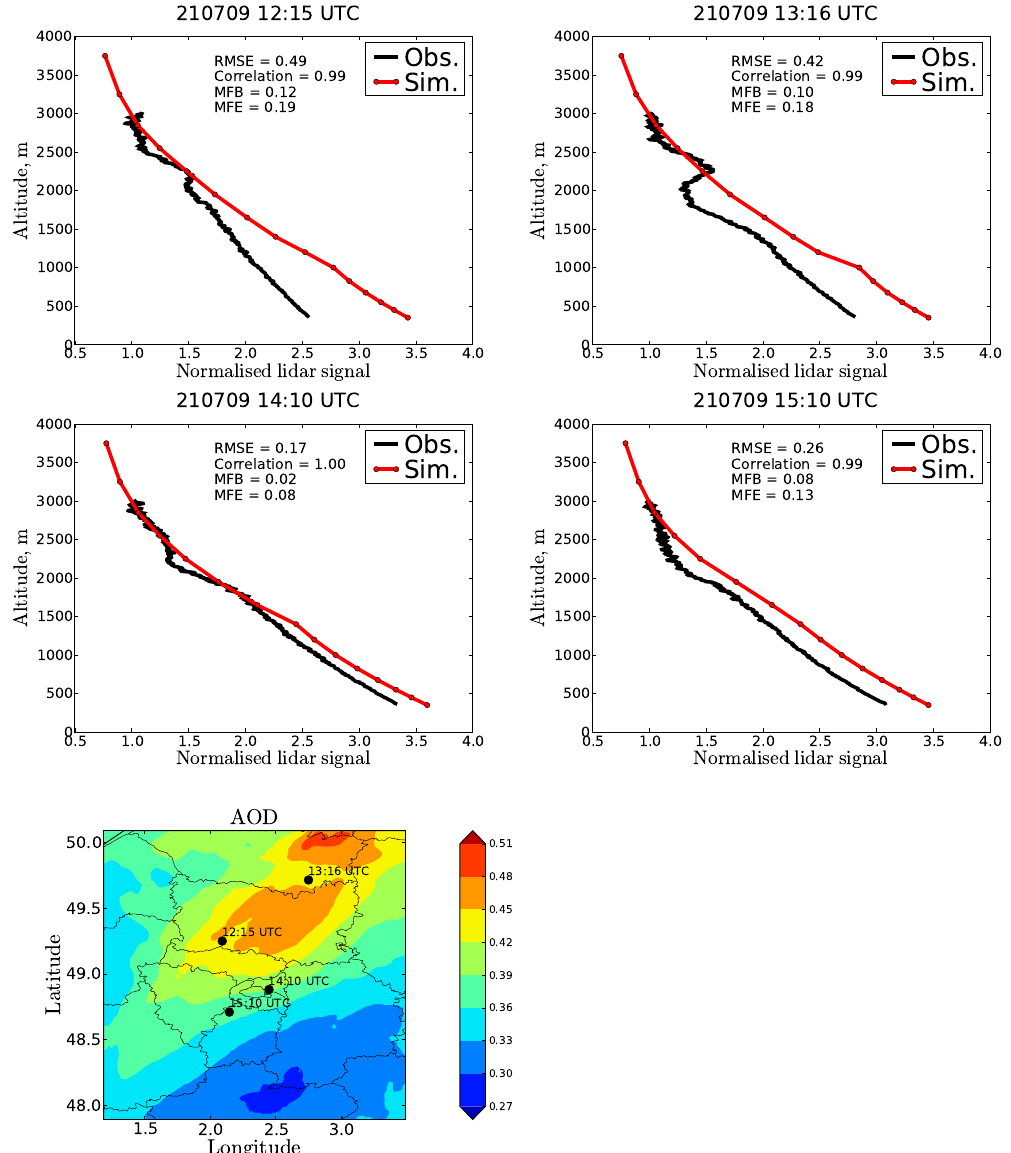
Fig. 7. Comparisons between the vertical profiles observed by GBML (black lines) and simulated by P OLYPHEMUS (red lines) on panel shows the positions of the different lidar profiles and the horizontal distribution of the mean of the AODs at 12:00, 13:00, 14:00 and